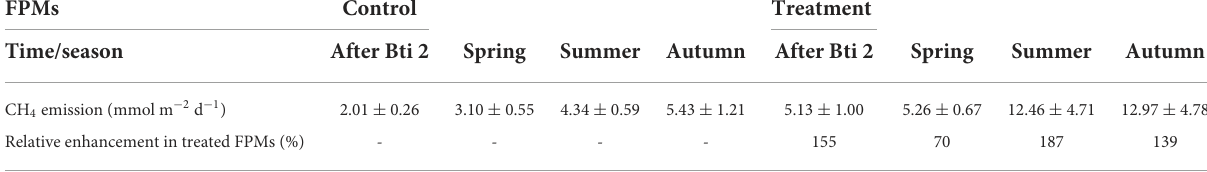
TABLE 2 Areal emission rates of CH 4 in the aquatic-terrestrial transition zone of untreated (Control) FPMs and those treated with Bti (Treatment), and the relative enhancement of CH 4 emissions from treated units.